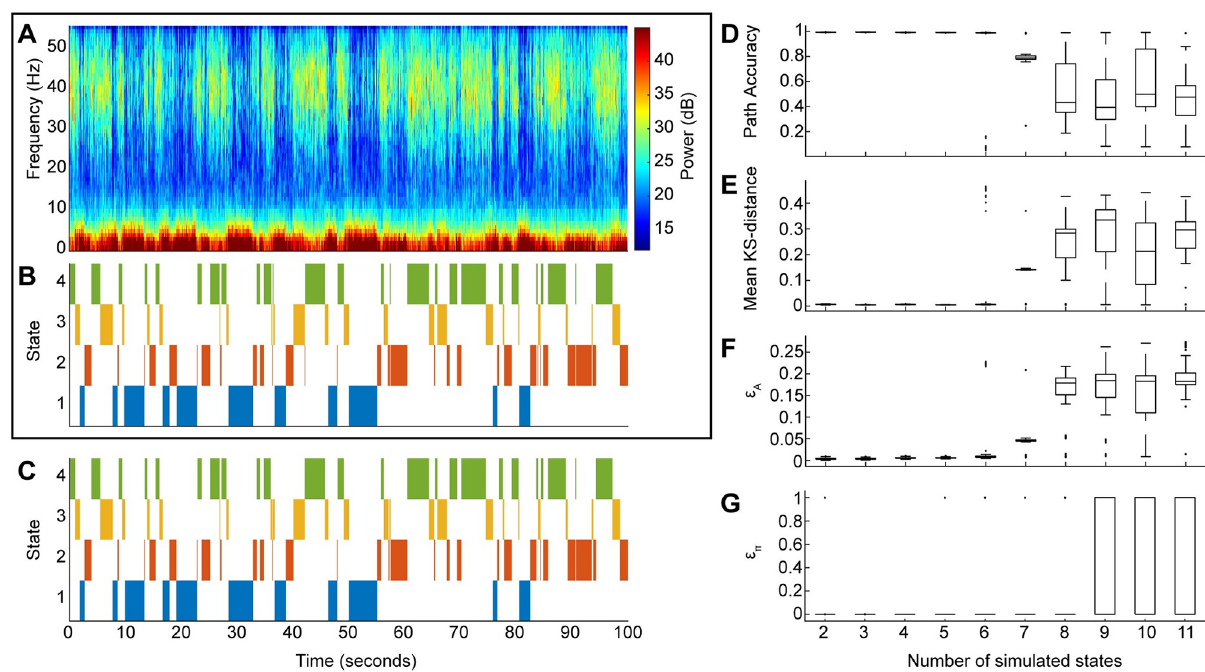
Fig 2. The beta-HMM tracks the dynamic structure of simulated spectrograms characterized by discrete state transitions (extracted from one sequence of ketamine-induced LFP in NHP MJ). (A) One realization of simulated spectrogram. (B) Markov path corresponding to the simulated spectrogram in panel A. (C) Optimal state trajectory estimated from simulated data in panel A via the beta-HMM analysis. (D-G) Goodness of fit analysis. Box-plots summarize the state path accuracy (Eq (10)) in panel D, the KS-distance between the estimated and the actual state-specific and frequency band-specific beta distributions (averaged across all states and all frequency bands) in panel E, the relative error in transition matrix (Eq (11)) in panel F, and relative error in the initial state probabilities (Eq (12)) in panel G. For each specified number of states, 100 realizations of spectrograms were simulated and the beta-HMM analysis was performed on